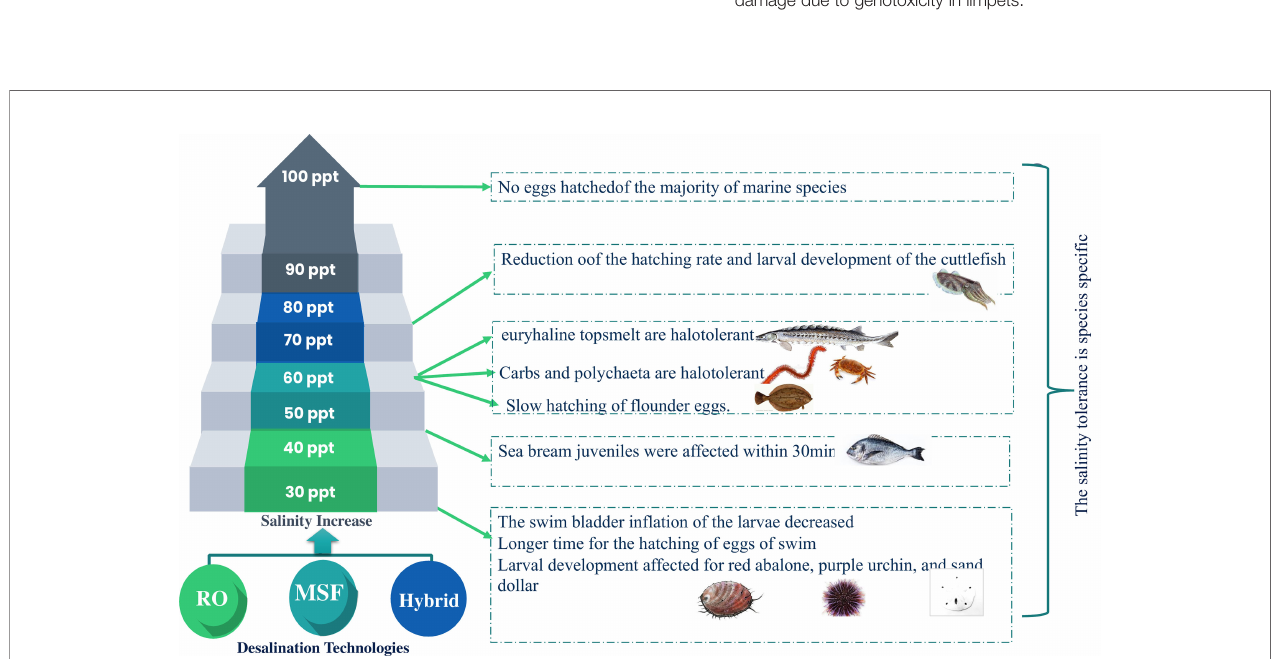
FIGURE 2 | Potential impacts of the brine ’ s salinity on fauna (vertebrate and